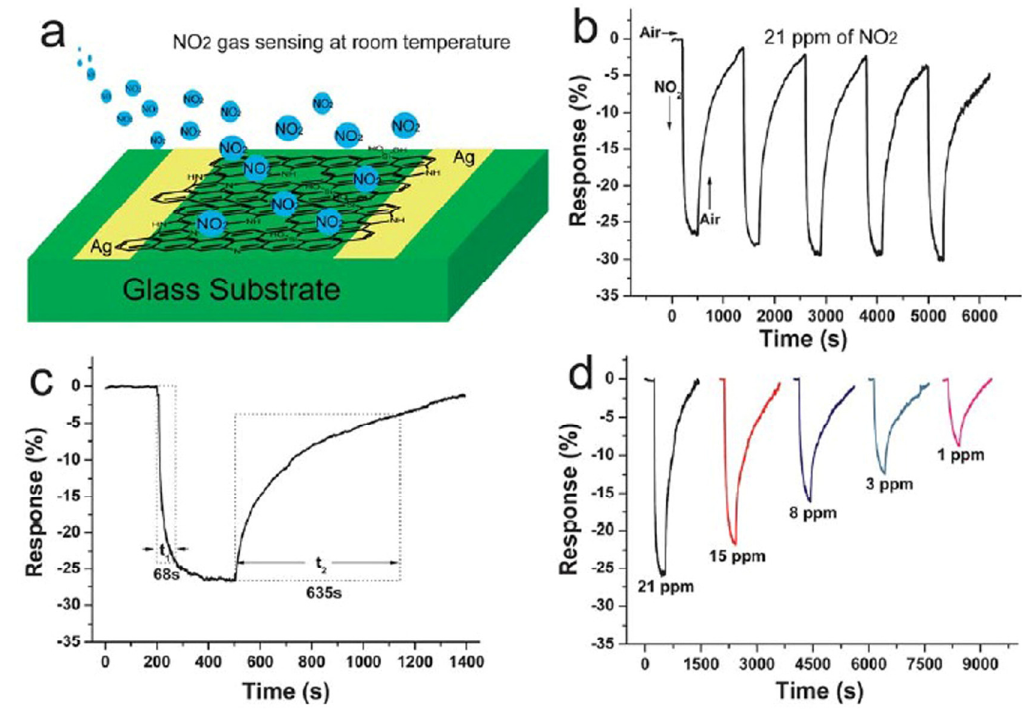
Figure 4. ( a ) NO 2 sensor; ( b ) the response of NSi-GNS-400 to 21 ppm of NO 2 ; ( c ) response and recovery time; and ( d ) response to NO 2 with varying concentrations. Reprinted with permission from Ref. [127]. Copyright, 2013, Royal Society of